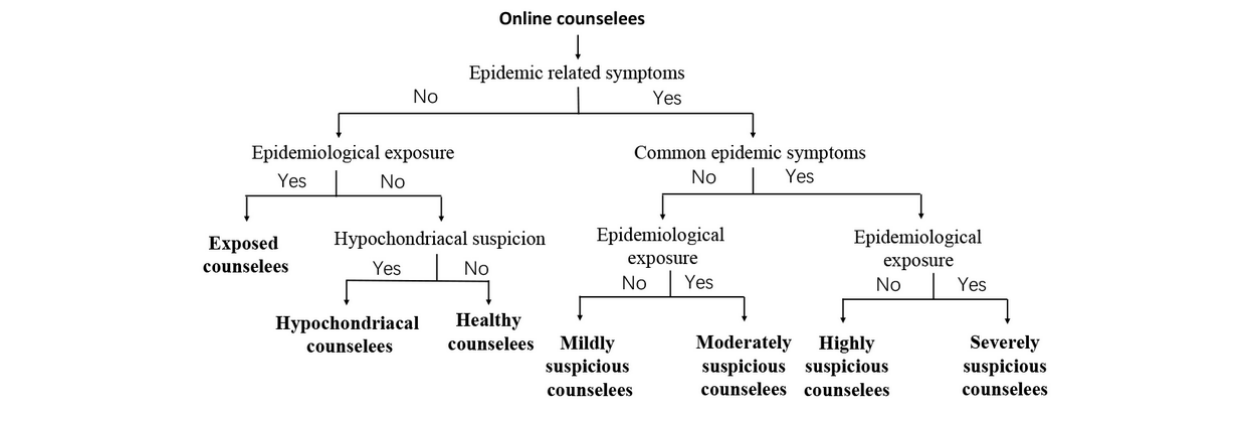
Figure 1. Classification of different